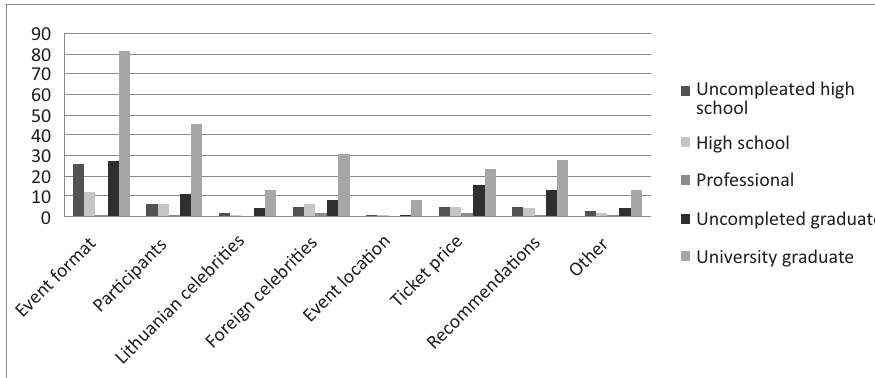
Fig. 6. Correlation between festival selection and